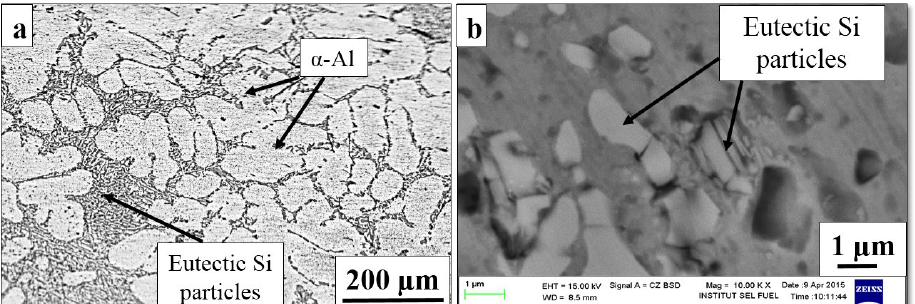
Figure 1. Microstructural features of as-cast Al–7Si alloy: ( a ) optical micrograph; ( b ) SEM morphology of eutectic Si.